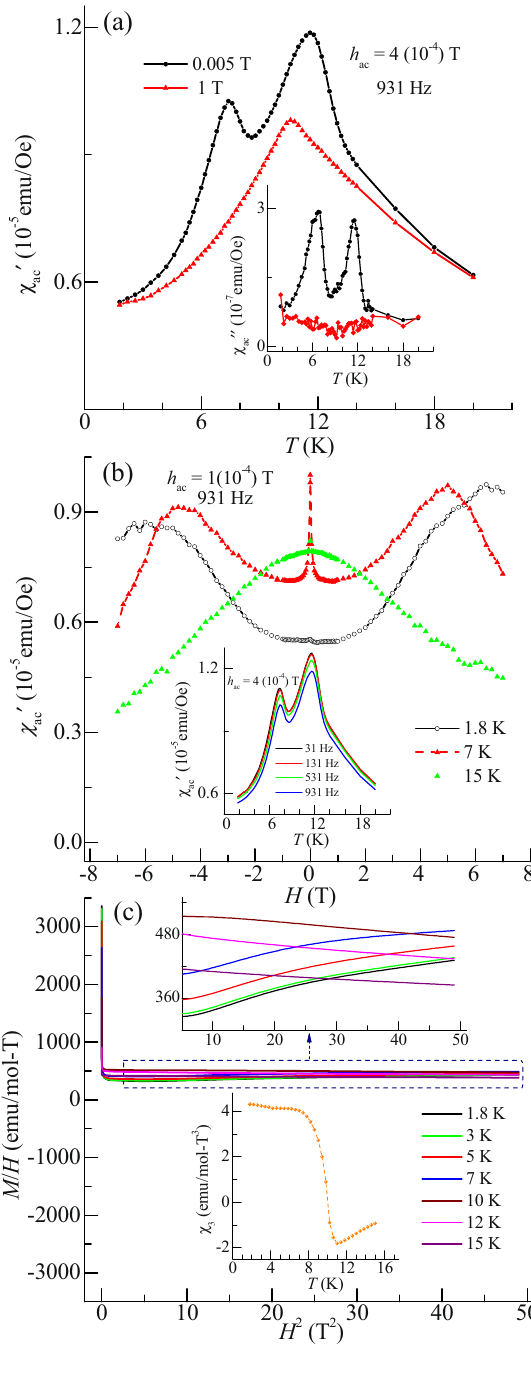
Figure 3. ( a ) Temperature dependent real part of AC susceptibility ( χ′ superimposed DC field of 0.005 and 1 T; at 931 Hz. Inset: imaginary part of AC susceptibility ( χ″ similar condition. ( b ) DC magnetic field (7 to − 7 T) dependent χ′ 1 (10 − 4 ) T AC field. Inset: Temperature response χ′ and superimposed DC field of 0.005 T. ( c ) H 2 dependent M / H at different temperatures. Upper inset: Expanded portion of the same curves in field range 2-7 T. Lower inset: Temperature response of χ 3